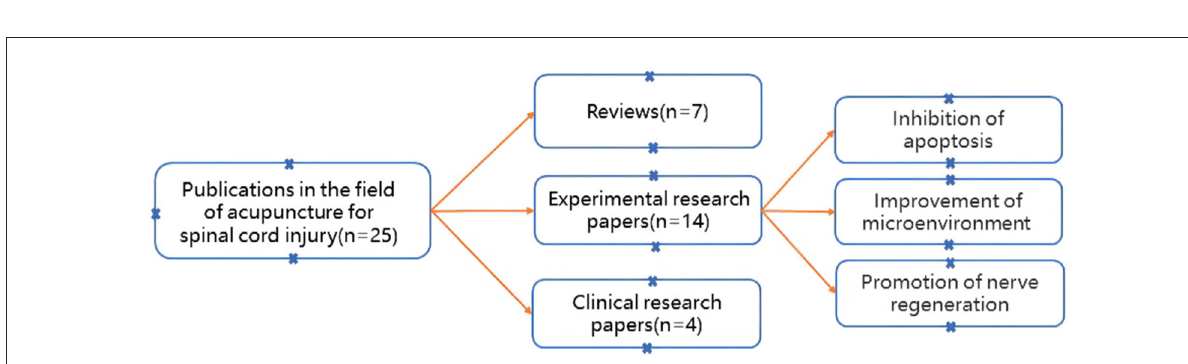
FIGURE9 Classification of publications (annual citation rate ≥ 2.5) for acupuncture treatment